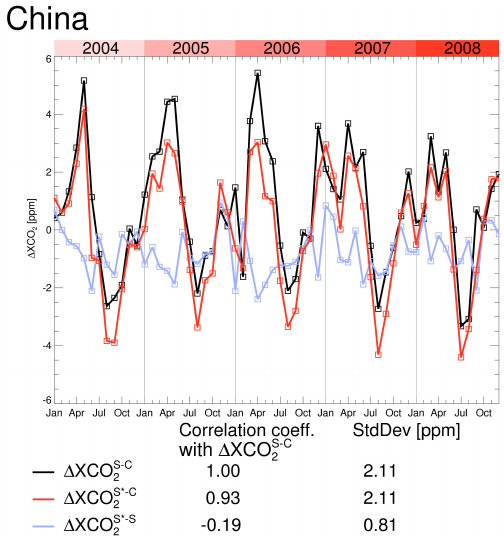
Fig. 10. As Fig. 9 but for Fig. 9. Results of the comparison between CarbonTracker XCO 2 and WFMDv2.1 XCO 2 with and without scan-angle- bias correction for Southern Africa. Top: The difference between WFMDv2.1 XCO 2 and CarbonTracker XCO 2 ( 1 XCO S − C ) is 2 shown in black and the difference between the scan-angle-bias cor- ∗ − C rected WFMDv2.1 XCO 2 and CarbonTracker XCO 2 ( 1 XCO S ) 2 is shown in red. The light blue curve represents the difference between scan-angle-bias corrected WFMDv2.1 XCO 2 and uncor- ∗ − S rected XCO 2 ( 1 XCO S ). Bottom: correlation coefficients ( r ) be- 2 tween these differences and 1 XCO S − C and corresponding standard 2 deviations.